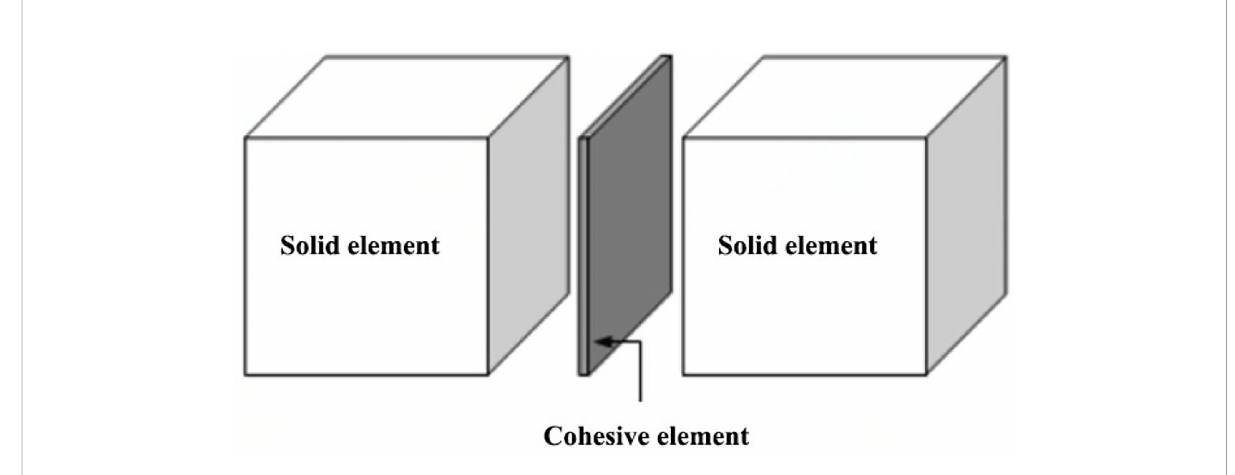
FIGURE 1 The cohesive element method (Hillervborg et al.,